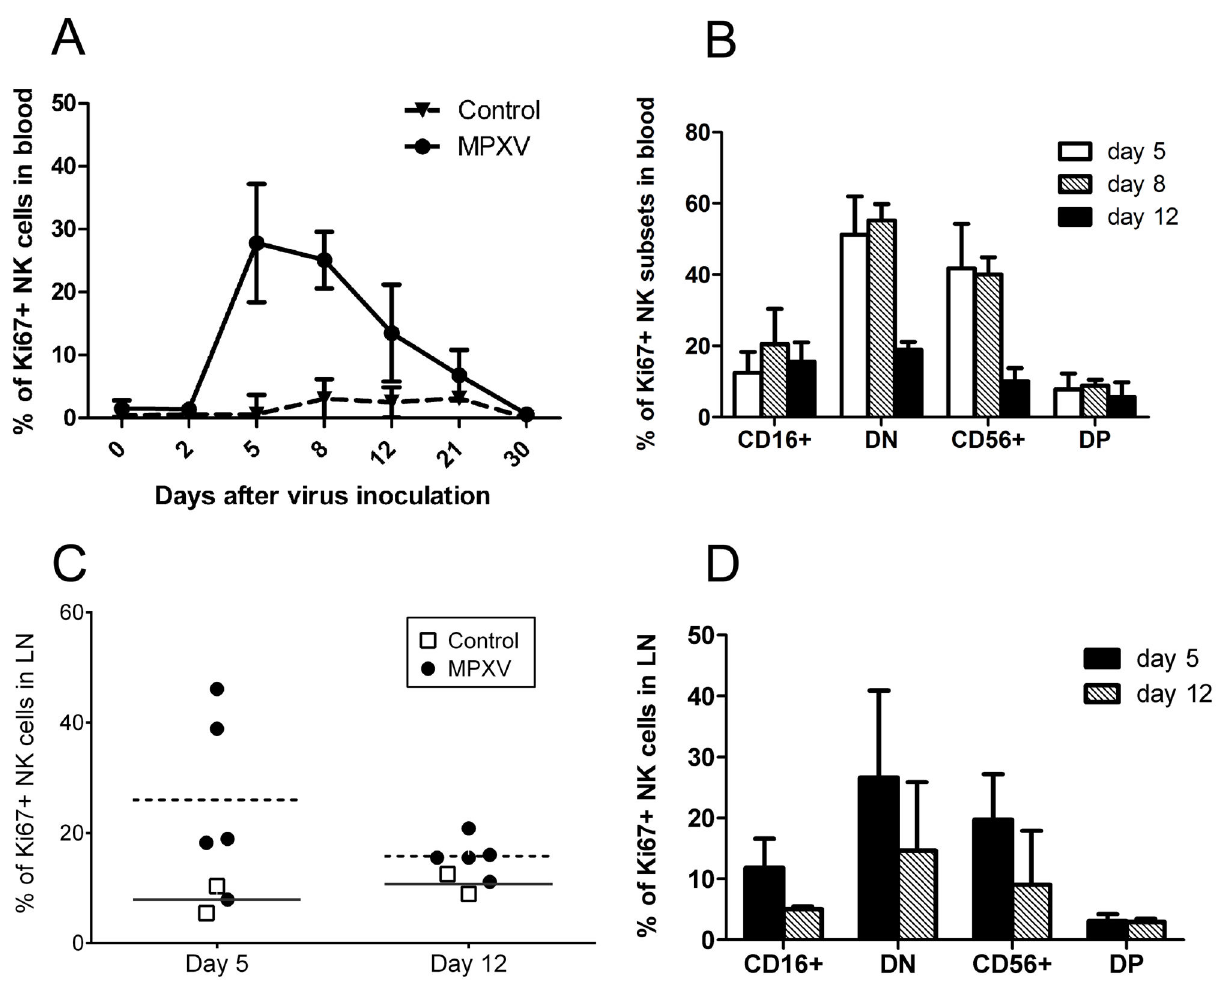
Figure 3. Proliferation of NK cells from blood and lymph nodes upon MPXV infection. A) Frequency of Ki67+ NK cells within the NKG2A+ NK cell gate. B) Frequency of Ki67+ NK cells in each NK subset from days 5, 8, and 12 blood samples. C) Ki67+ NK cell frequency within the NKG2A+ cell gate from days 5 and 12 biopsies of LNs. D) Ki67+ cell frequency in each NK subset